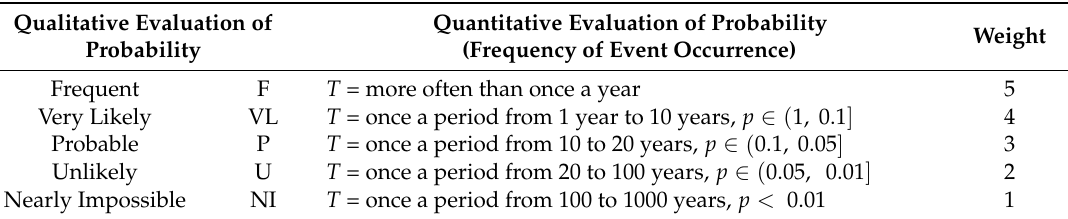
Table 4. Scale of probability (frequency of event